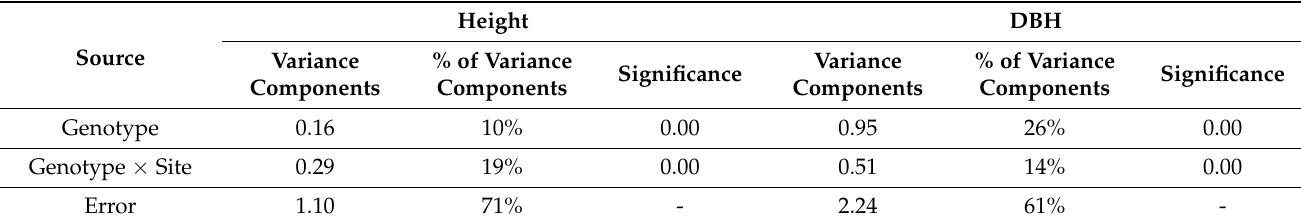
Table 4. The random effect.